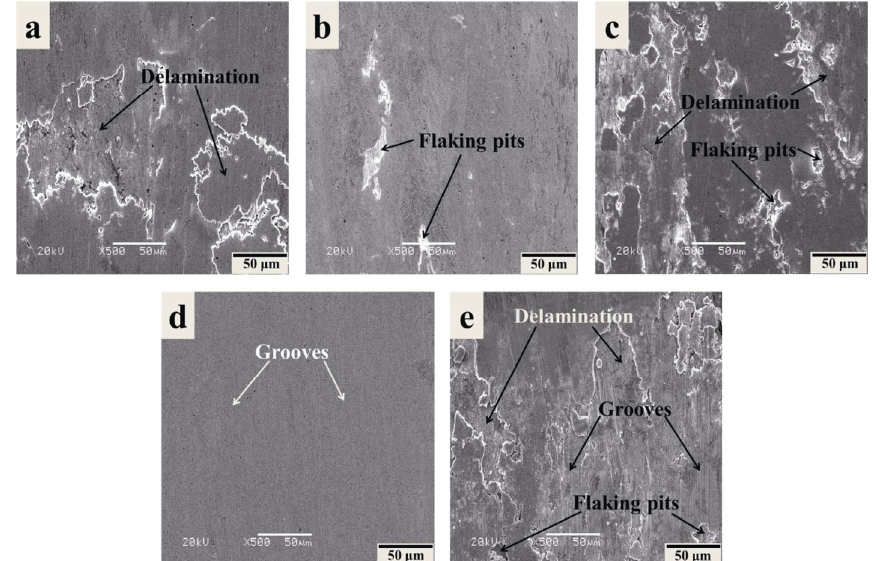
Fig. 8 SEM images of the worn surface of composite G1: (a) 25 ºC, (b) 200 ºC, (c) 400 ºC, (d) 600 ºC, and (e) 800 ºC.